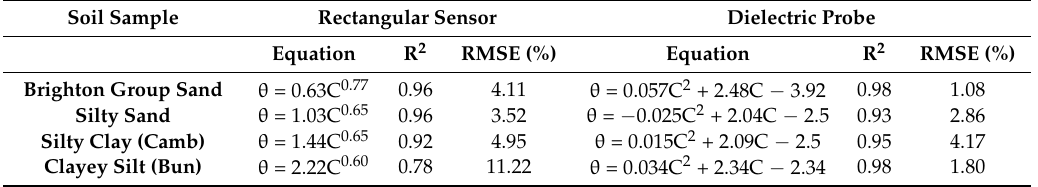
Table 4. Summary of the Rectangular sensor and dielectric probe performance against each soil sample. Soil Sample Rectangular Sensor